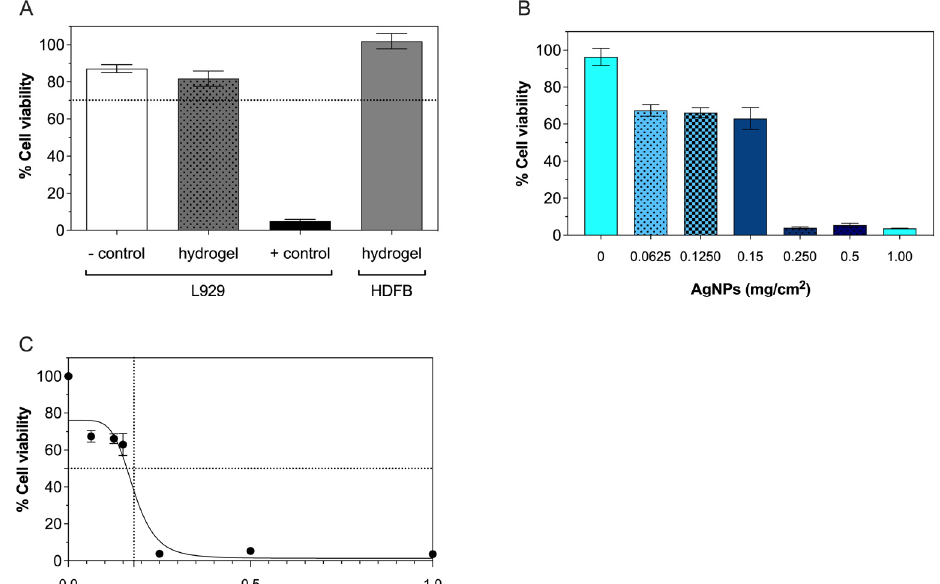
Figure 7. Cytocompatibility evaluation of ( A ) hydrogel sheets with both L929 and HDFB cells and ( B ) AgNP-loaded hydrogel sheets at varied amounts of AgNPs with L929 cells. The dashed line at a cell viability of 70% in ( A ) presents the threshold of non-cytotoxicity. ( C ) Dose–response curve shows the estimation of the IC 50 by the nonlinear regression analysis with the four-parameter logistic curve fit.